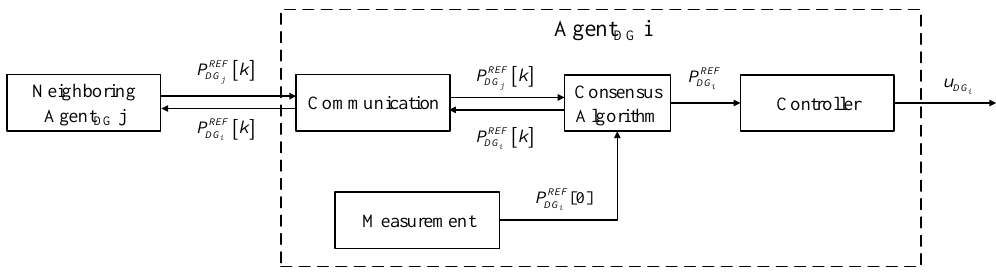
Figure 6. Agent and control structure of DG.